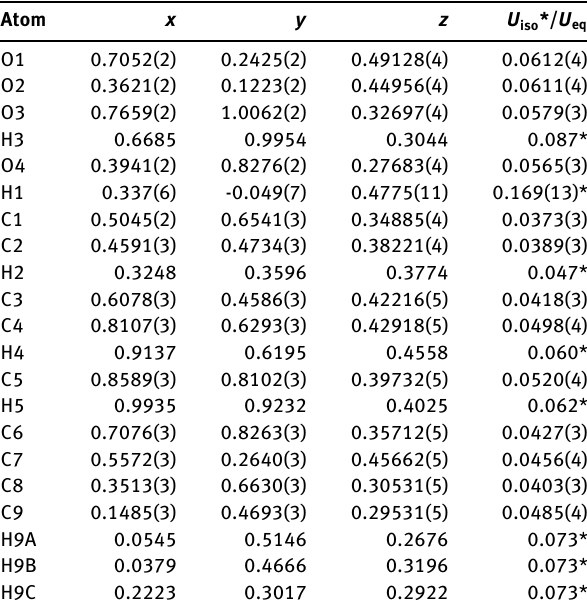
Table 2: Fractional atomic coordinates and isotropic or equivalent isotropic displacement parameters (Å 2